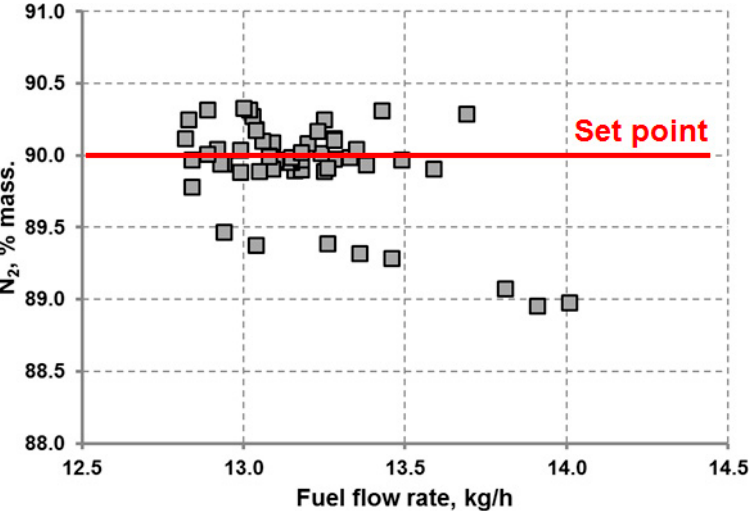
Figure 4. Distribution of the actual mass percentage of nitrogen, with respect to the set point, as a function of the fuel flow rate.